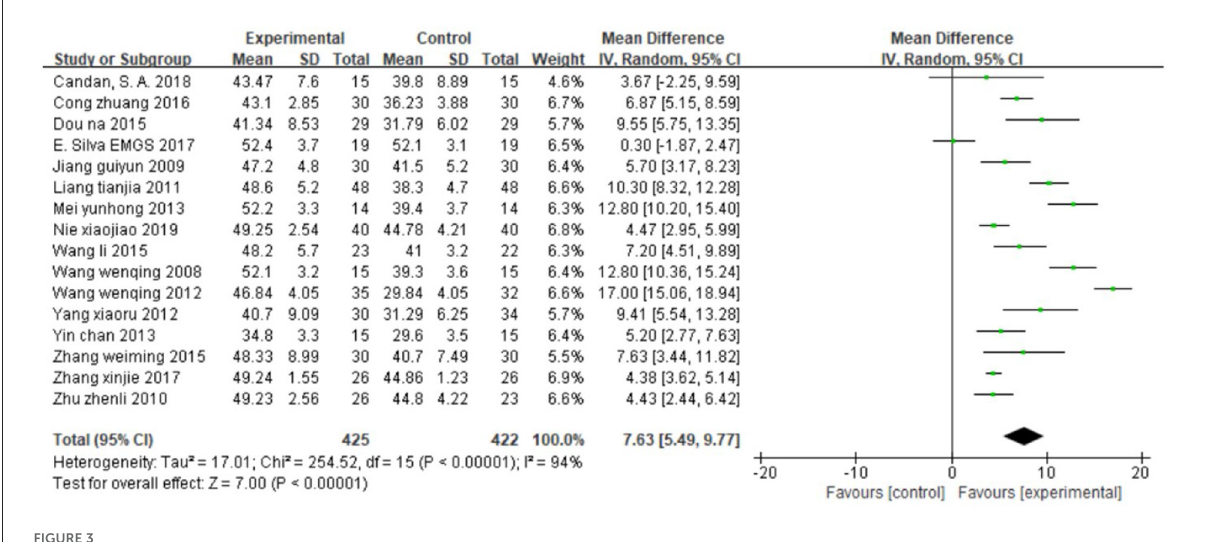
FIGURE3 Forest plot. CIMT vs. conventional physiotherapy on the Berg balance scale.